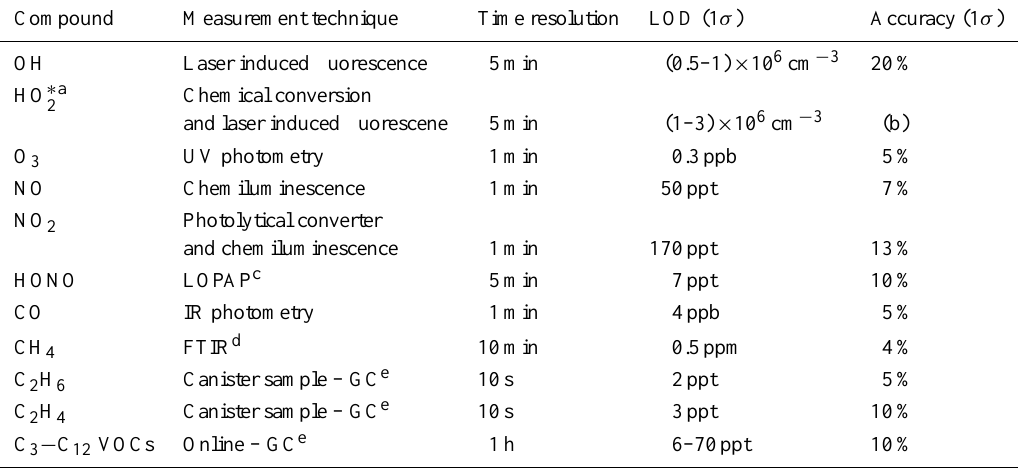
Table 1. Instruments for atmospheric trace gas measurements at Backgarden in summer 2006.